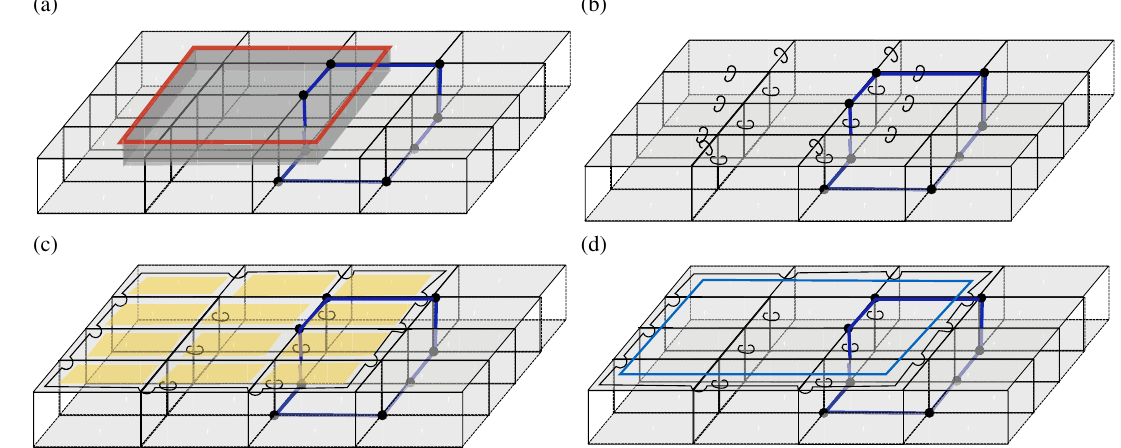
FIG. 11. Symmetry action and surface semion strings. (a) Acting with the symmetry operator R on all spins inside the gray region x creates a bulk domain surface (the boundaries of the gray box) that ends on a surface domain wall (shown in red). This operation twists each singlet-chain link piercing the domain surface by U (or U † x ). Performing this transformation twice multiplies the wave function by x a phase factor ð − 1 Þ n s , where n is the number of edges piercing the domain surface that carry semion labels. (b) Diagrammatically, this s can be represented by encircling each edge with a small semion loop. (c) Acting with a product of plaquette operators on the shaded plaquettes reproduces this operator in the bulk but leaves a large loop running below the surface along the domain wall. (d) To obtain the correct phase factor, an additional semion string (shown here in blue) must be added at the surface along the domain wall. Note that, for simplicity, we suppress the point splitting of the cubic lattice in this